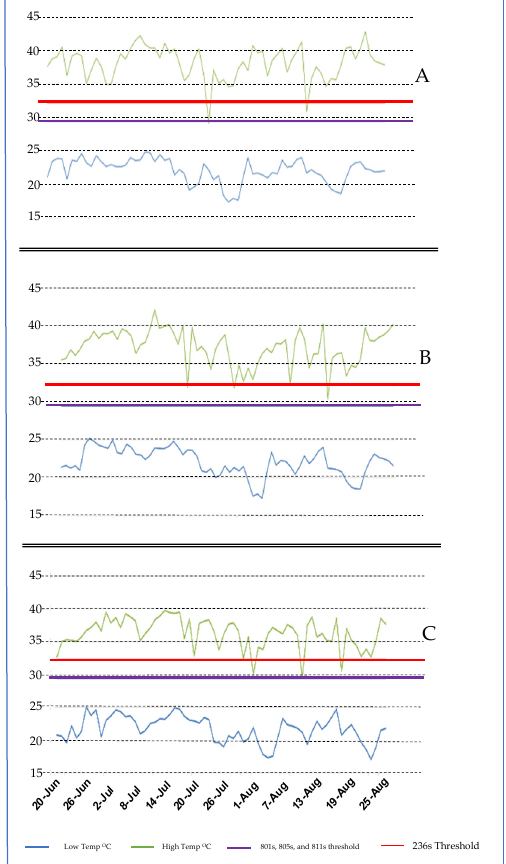
Figure 2. Temperatures in three locations in 2018 of ( A ) PTRS, ( B ) RREC, and ( C ) SREC; red line, temperature threshold for inducing sterility in 236